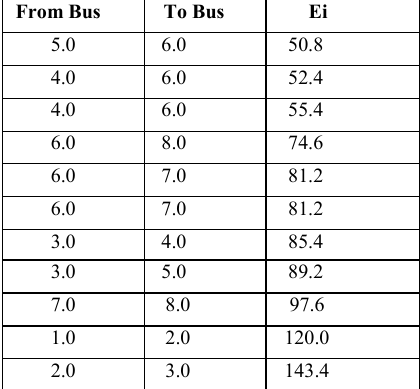
Fig.13 Optimized power system of Dehradun (2015) after addition of only one line TABLE. 8 Ei OF THE SYSTEM WITH NO